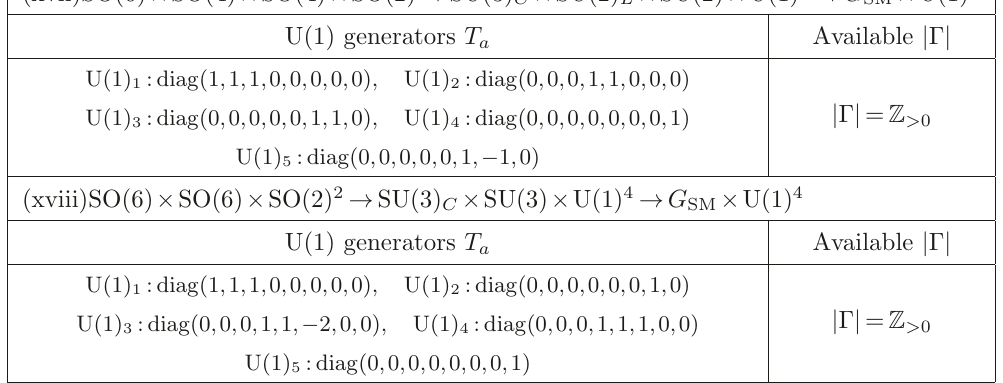
diag( 1 , 1 , 1 , 0 , 0 , 3 , 3 , 3) where the sign is taken in the random order. 6 − − − ± ± ±